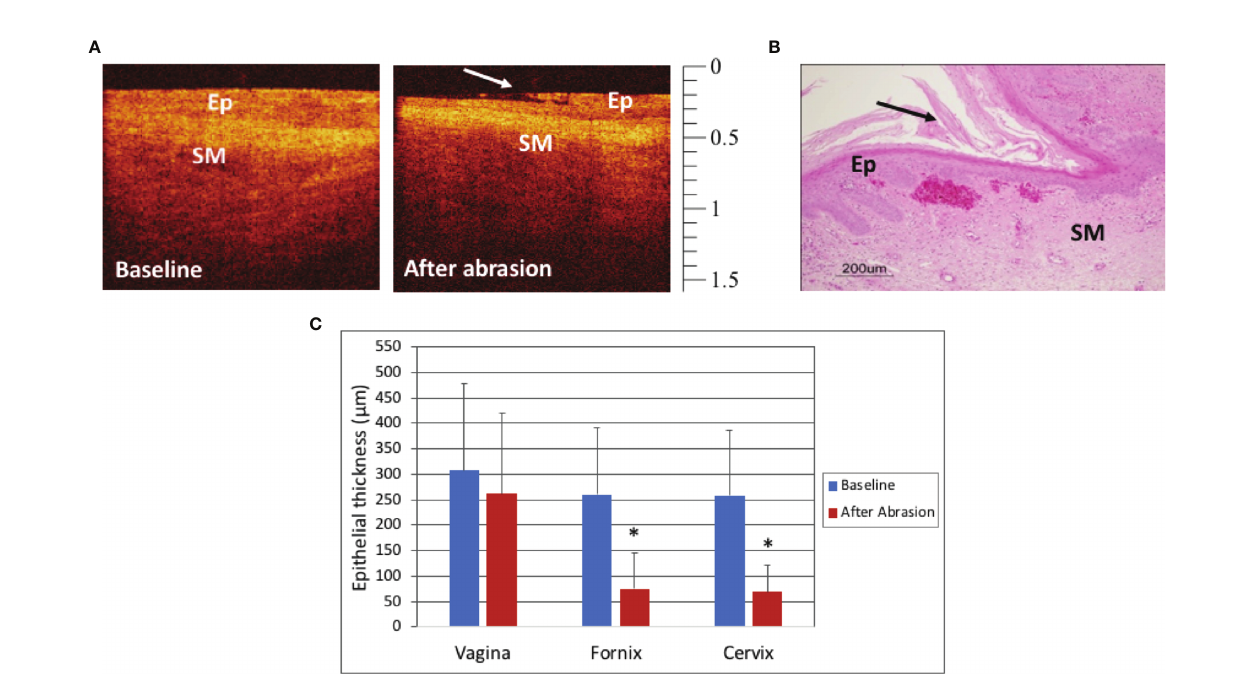
FIGURE 3 | Optical Coherence Tomography (OCT) and Histology Findings after mechanical abrasion - OCT image of the cervix before and after mechanical abrasion (A) . The epithelium (Ep) is visibly thinned shortly after the abrasion was performed. The long arrow indicates the edge of epithelial disruption. (OCT calibration bar is in mm, with small tick mark = 100 m m). Hematoxylin and Eosin (H&E) staining of abrasion in the vagina of a mensing macaque ( B , scale bar 200 m m). Epithelial thickness (ET) measures of the vagina, fornix, and cervix before and after mechanical abrasion showed that ET in the fornices and cervix was thinned after abrasion ( C , p<0.001), however there was no signi fi cant change in vaginal ET (p=0.91). Error bars represent standard deviation and asterisks (*) indicate signi fi